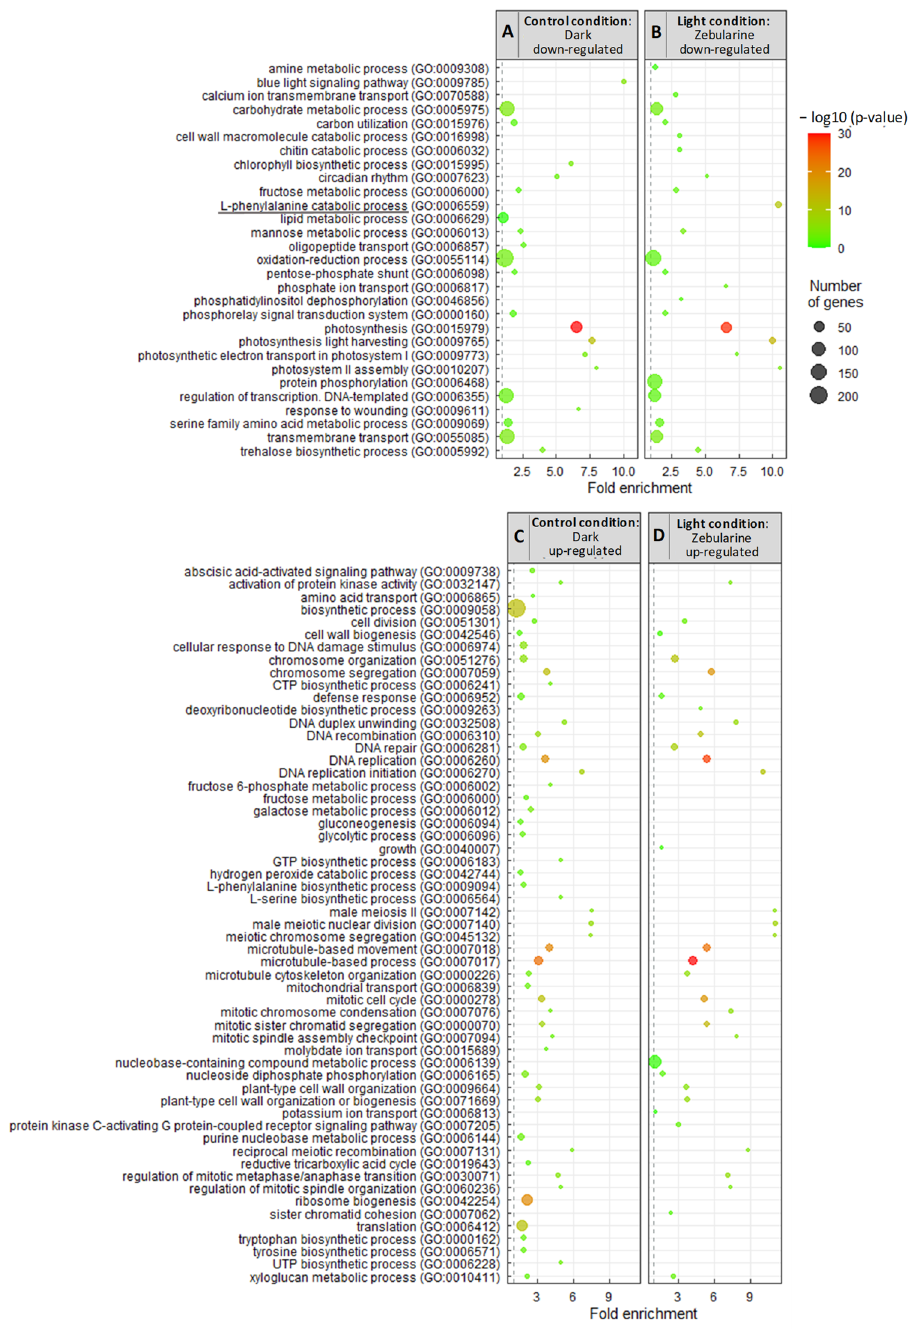
Figure 6. Identification of the differentially expressed gene (DEG) biological functions by a GO enrichment analysis revealed a high similarity between the genes which were deregulated by light in the control cells and the genes which were deregulated by zebularine in the light. The GO analysis (biological functions) was conducted for the genes which were down-regulated in the DD samples compared to the LD samples ( A ), down-regulated in the LZ50 samples compared to the LD samples ( B ), up-regulated in the DD samples compared to the LD samples ( C ), and up-regulated in the LZ50 samples compared to the LD samples ( D ). The common biological process between light- and dark- deregulated genes (comparison between Figures 6 and 7) is underlined.